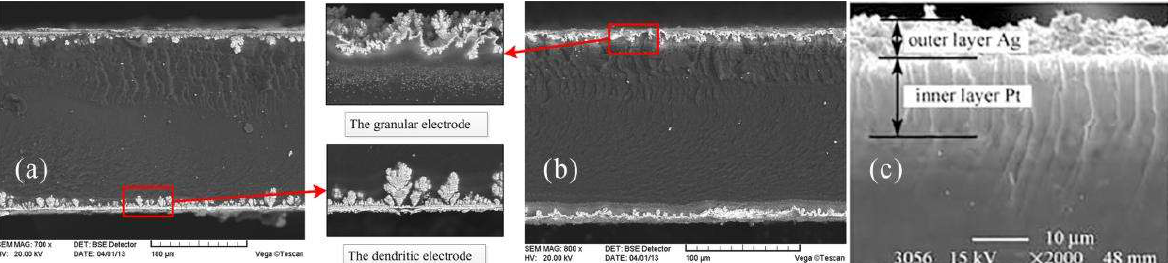
Figure 11. Electrode morphology of IPMC with different metal types. ( a ) Dendritic Au electrode. ( b ) Granular Pd electrode [82]. ( c ) Layered Pt electrode [83].